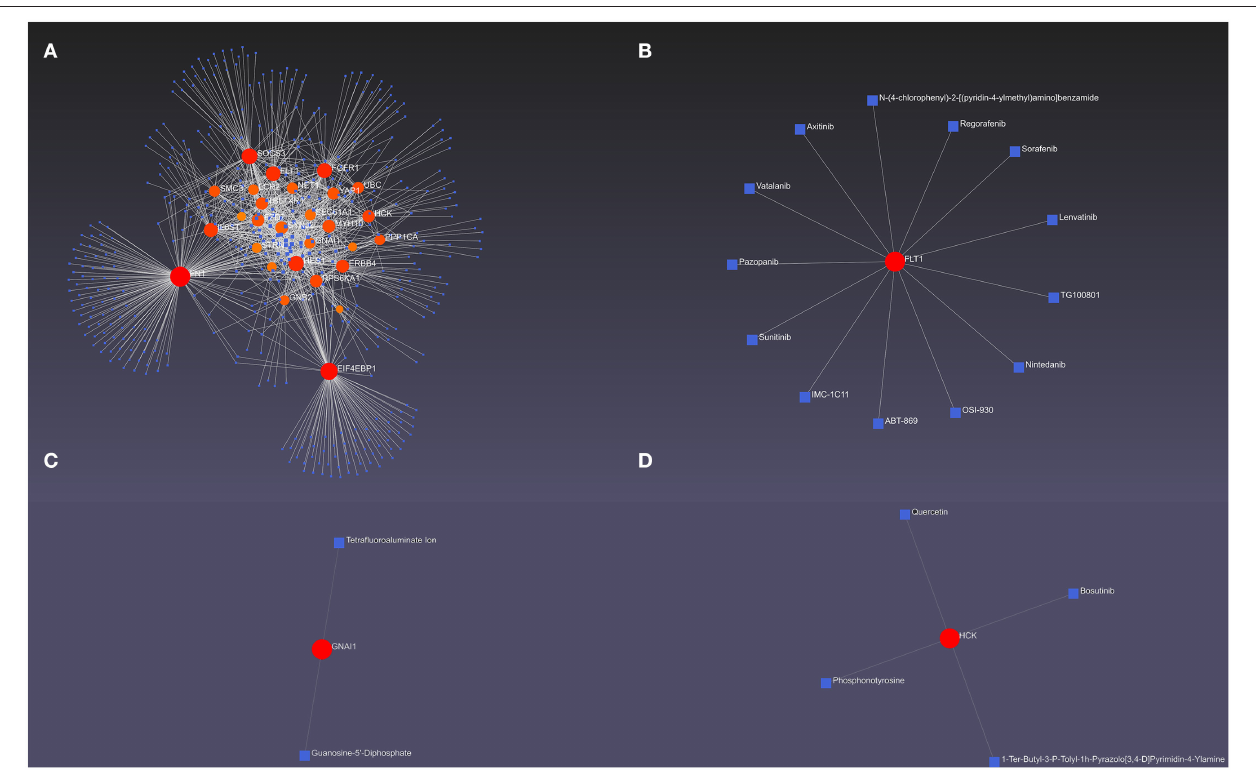
FIGURE 4 | The hub differentially expressed macrophages-related genes (DEMRGs) and their interactions. (A) The hub DEMRGs-chemical interactions. (B–D) The hub DEMRGs, including FLT1 (B) , GNAl1 (C) , and HCK (D) and their drug interactions.